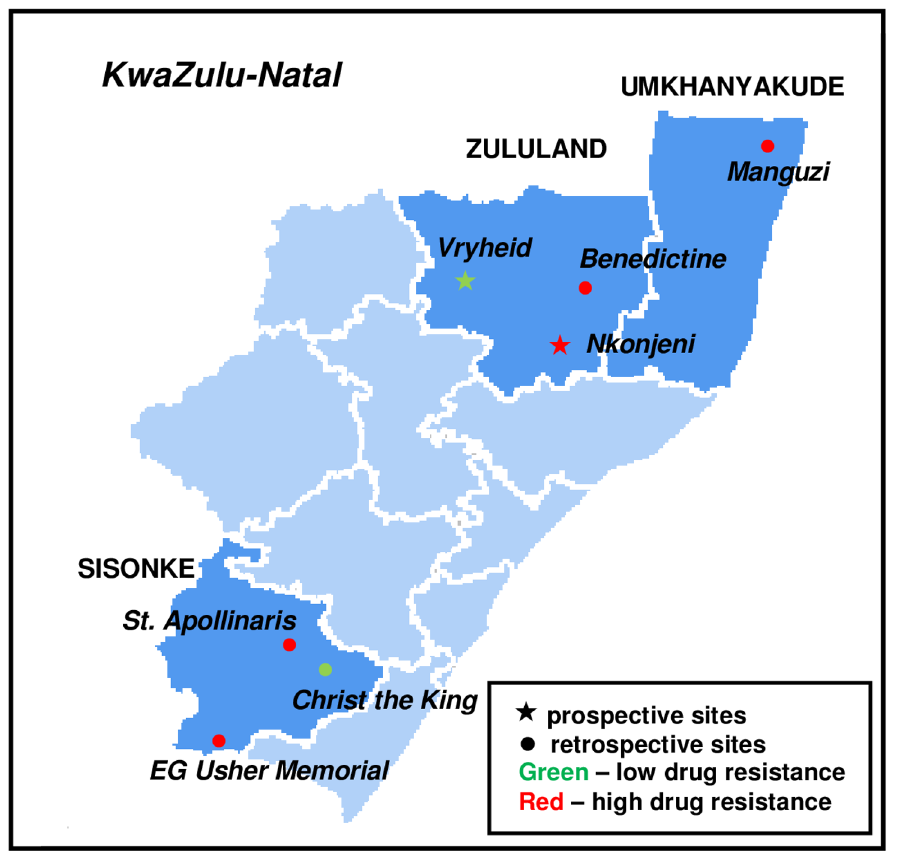
Fig 3. Study sites and risk classifications. Classifications of areas in KwaZulu-Natal Province, South Africa, as high or low risk for rifampicin resistant TB based on Lot Quality Assurance Sampling and GeneXpert testing. Areas in dark blue were included in the study. Modified from "Map of South Africa with district borders (2011)" (author : Htonl) under a CC Attribution-Share Alike 3 . 0 Unported license , with permission from Wikimedia Commons , original copyright 2011 . Available : https://commons.wikimedia.org/